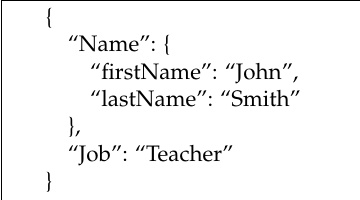
Algorithm 1. A representation in JSON.